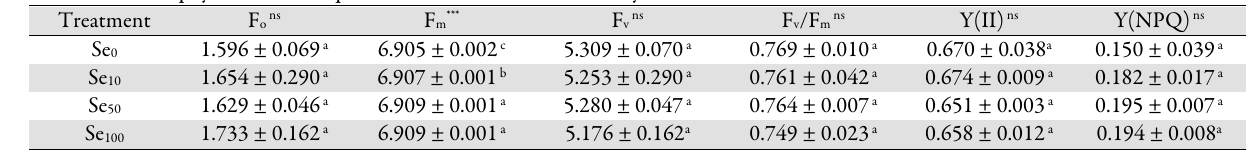
Table 4. Chlorophyll fluorescence parameters of broccoli as affected by Se treatments Treatment